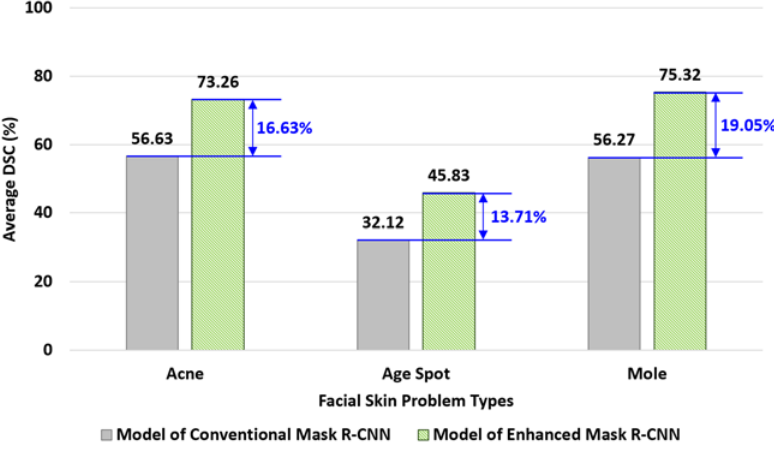
Figure 13. Comparing performances of conventional Mask R ‐ CNN and enhanced Mask R ‐ CNN models.